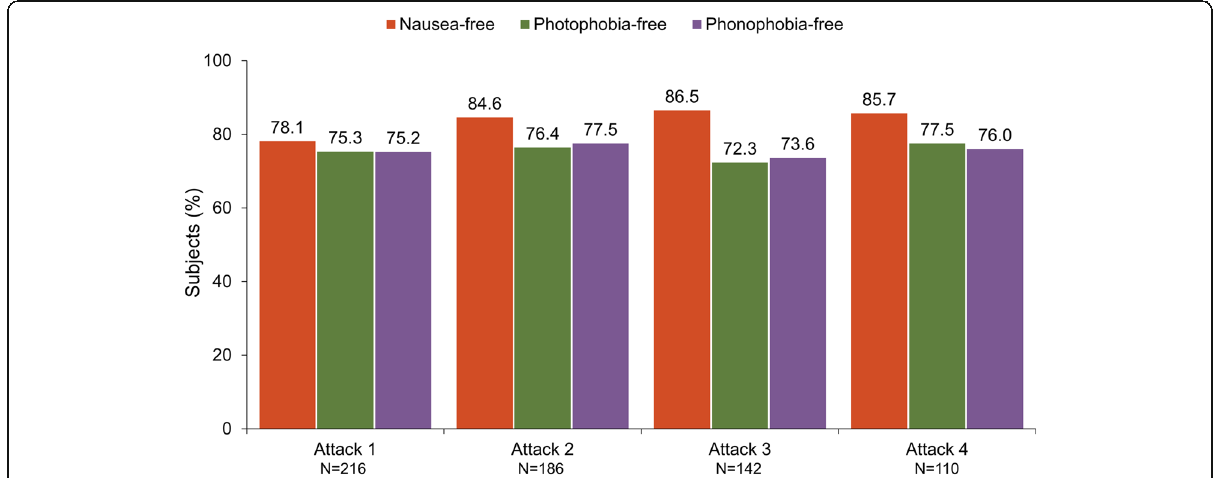
Fig. 3 Freedom from nausea, photophobia, and phonophobia at 2 h after treatment with